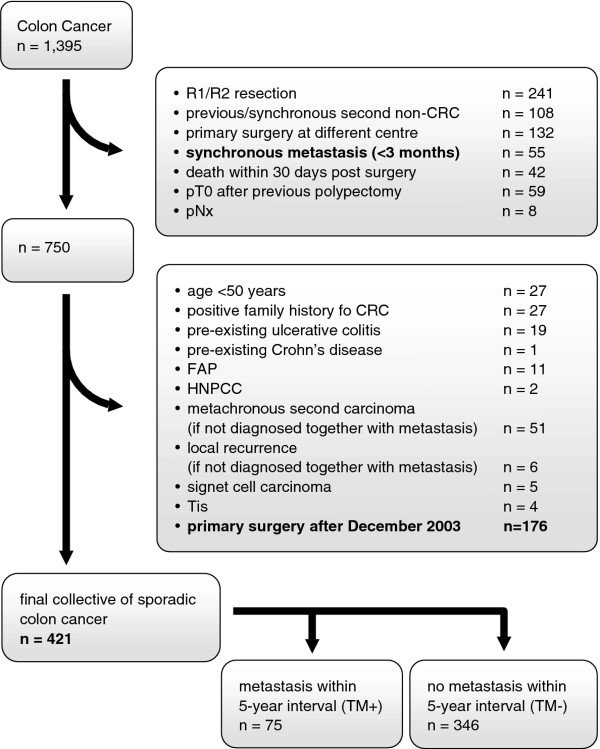
Exclusion criteria for patients who underwent surgery for Colon Cancer. The listed exclusion criteria were applied subsequently. CRC: Colorectal cancer, FAP: Familial Adenomatous Polyposis, HNPCC: Heriditary Non-Polyposis Colon Cancer, Tis: Carcinoma in situ.